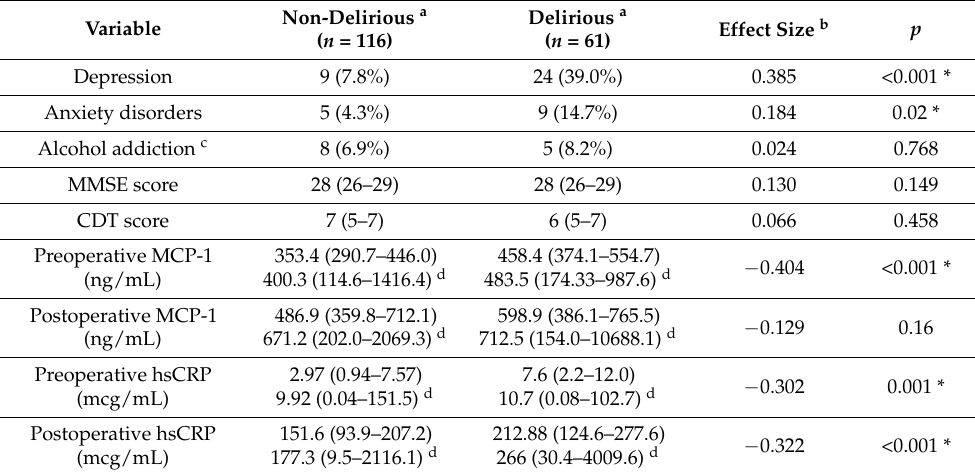
Table 2. Monocyte chemoattractant protein-1 and high-sensitivity C-reactive protein levels, and preoperative variables related to the mental condition of participants assessed in a univariate analysis.